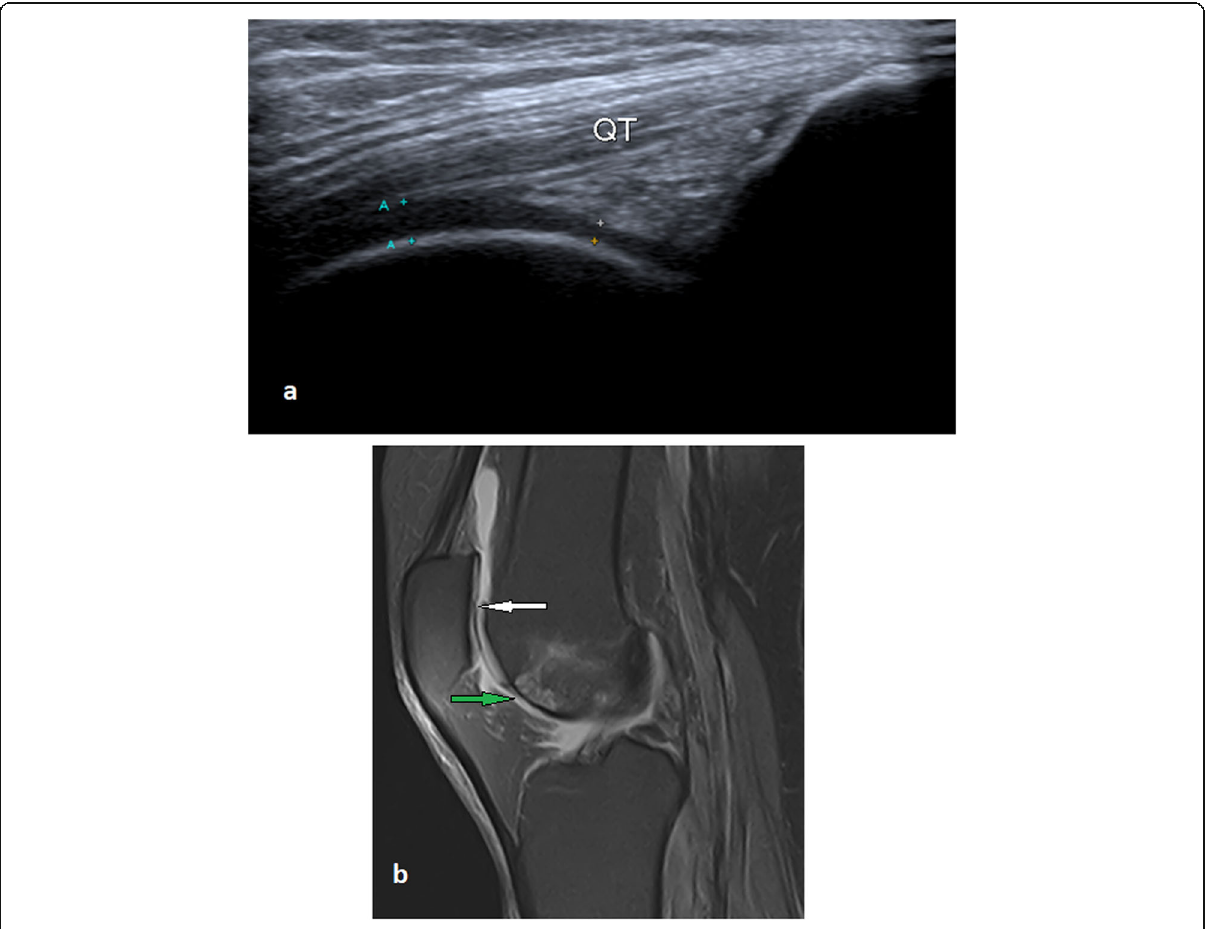
Fig. 6 A 54-year-old male with focal patellar and trochlear partial thickness cartilage loss, mild joint effusion, and anterior infrapatellar subcutaneous edema of the left knee. a Long axis ultrasound image of the left knee illustrates a focal thinning of the anteroinferior aspect of the trochlear cartilage. b Sagittal PDFS MRI illustrates partial thickness cartilage loss of the patella (white arrow), partial-thickness cartilage loss of the anteroinferior surface of the trochlear cartilage with subchondral bone marrow changes (green arrow), joint effusion, and anterior subcutaneous edema. QT, quadriceps